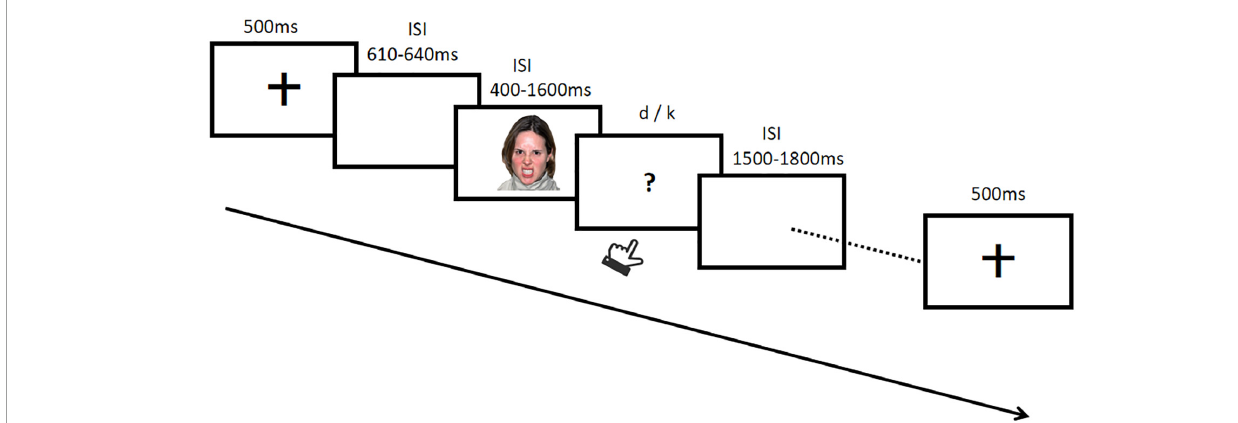
FIGURE1 Example of the procedure for a formal test trial.